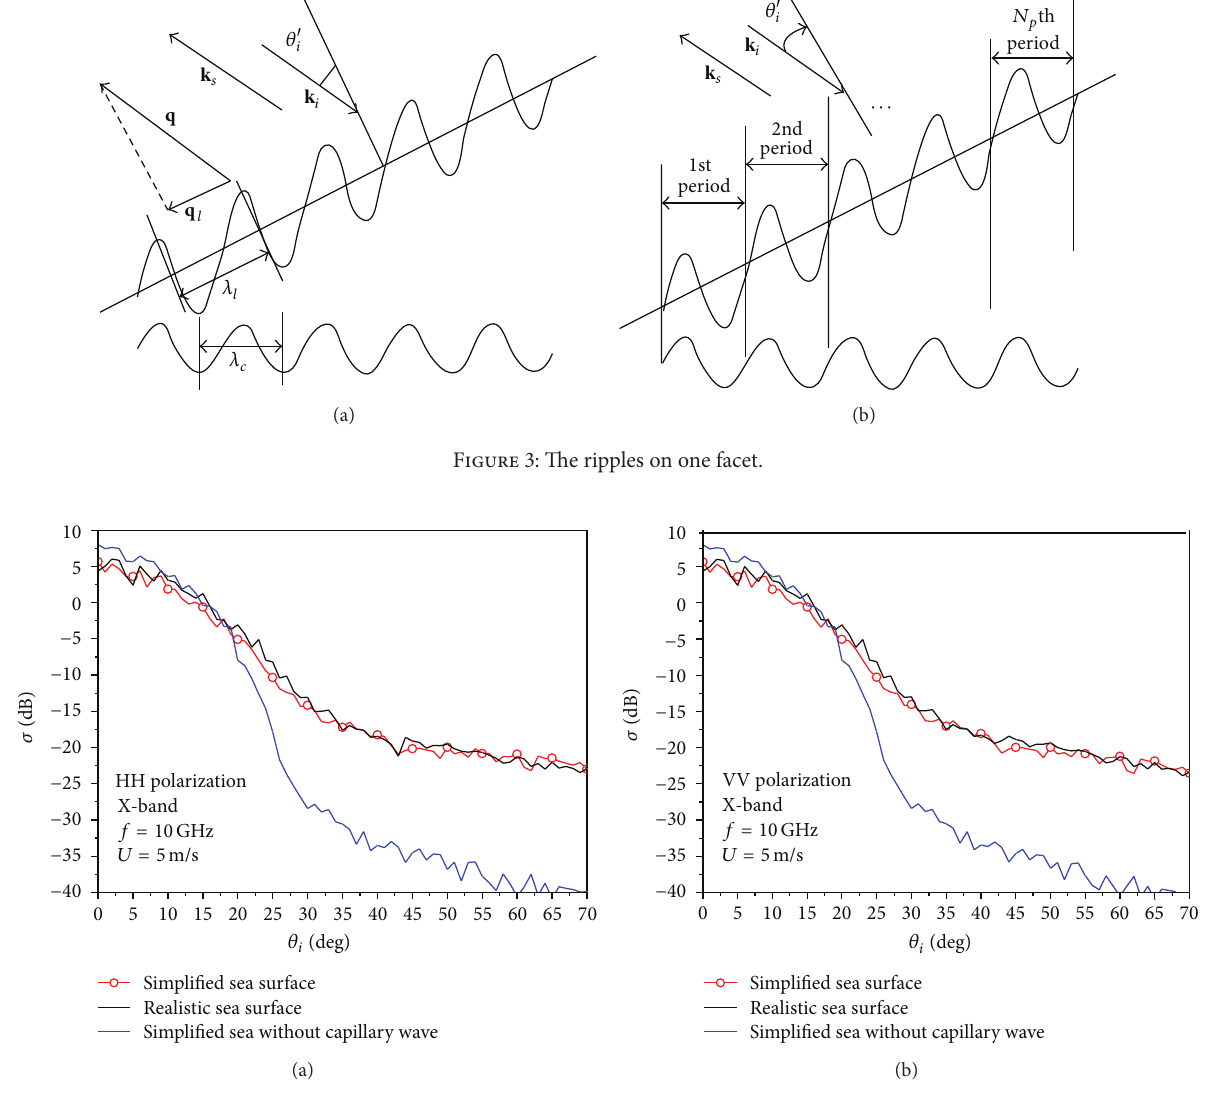
Figure 4: Backscattering coefficient from sea surface. (a) HH and (b)